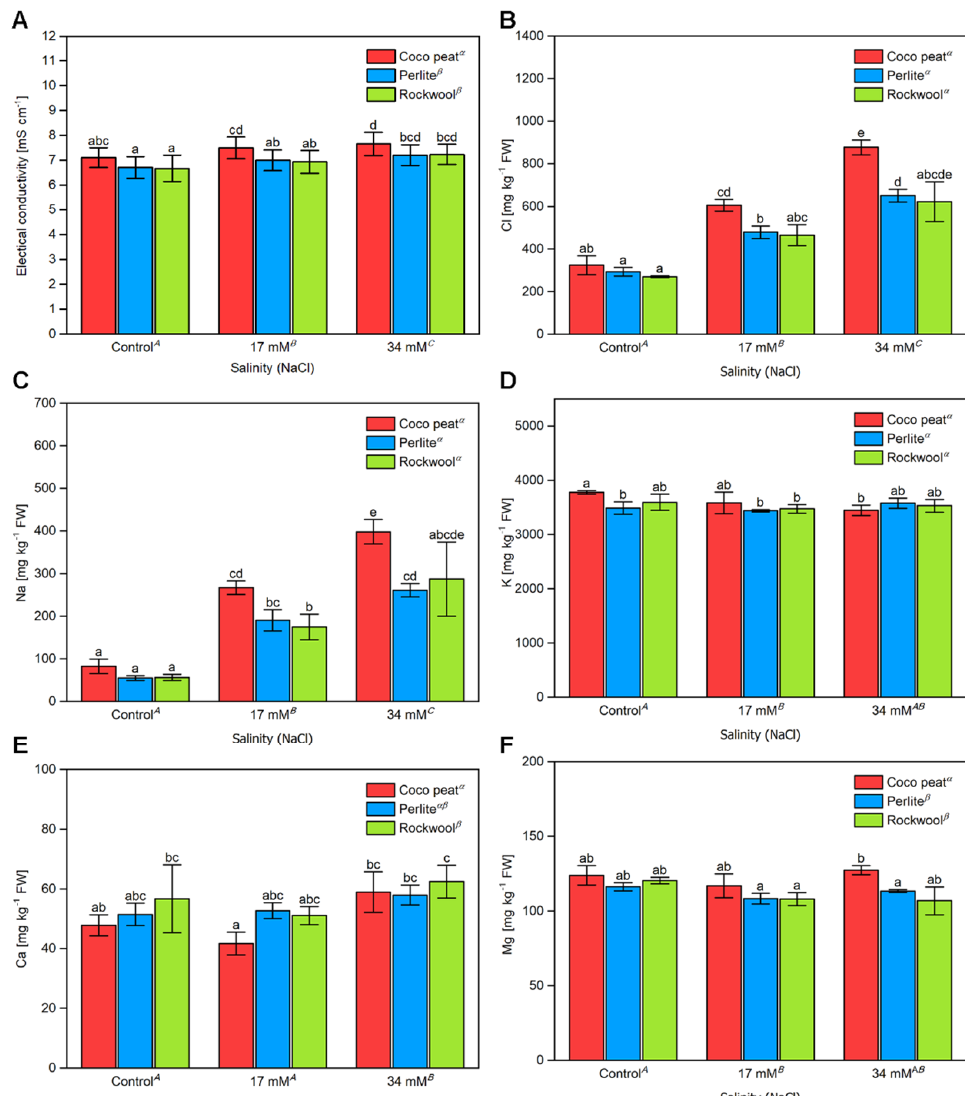
Figure 7. The electrical conductivity and mineral composition of cherry tomato fruit grown in different substrates with increasing salinity. The electrical conductivity ( A ) from 5 harvests between the 4 September 2017 and 17 October 2017. The chloride ( B ), sodium ( C ), potassium ( D ), calcium ( E ), and magnesium ( F ) content of cherry tomato fruits from the 11 September 2017 and 10 October 2017 grown in coco peat, perlite and Rockwool with increasing salinity by NaCl in the nutrient solution. The error bars represent the SD. Upper-case letters compare the salinity treatments; Greek letters compare different substrates, lower-case letters within the graph compare single mean values of the treatments. The raw data are available in Supplementary File S1.